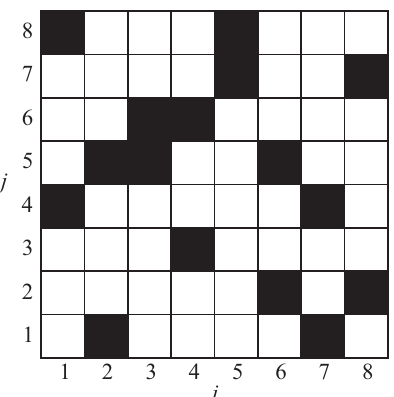
Figure 1. Coupling architecture. Black squares show the existing (nonzero) couplings from the j -th to the i -th oscillator and white squares correspond to nonexisting (zero)